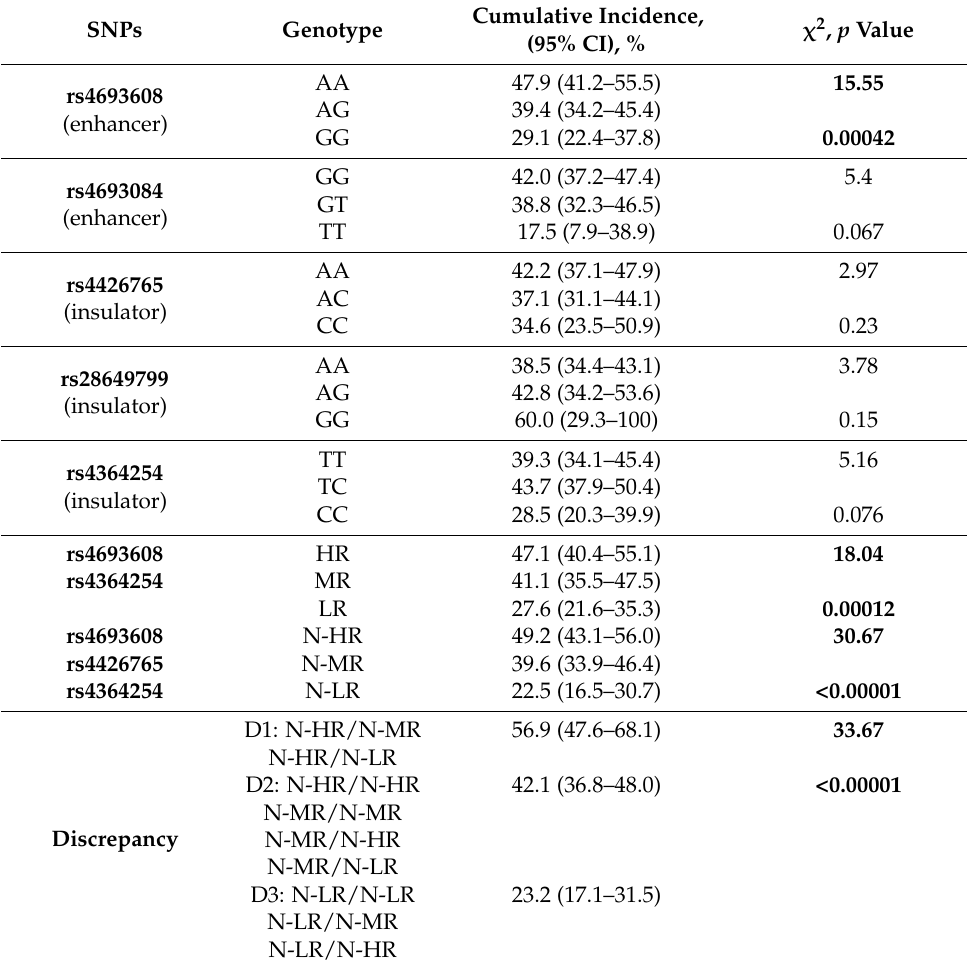
Table 2. Univariate analysis of cumulative incidence of clinically significant (II–IV) acute GVHD in association with patient enhancer and insulator HPSE gene